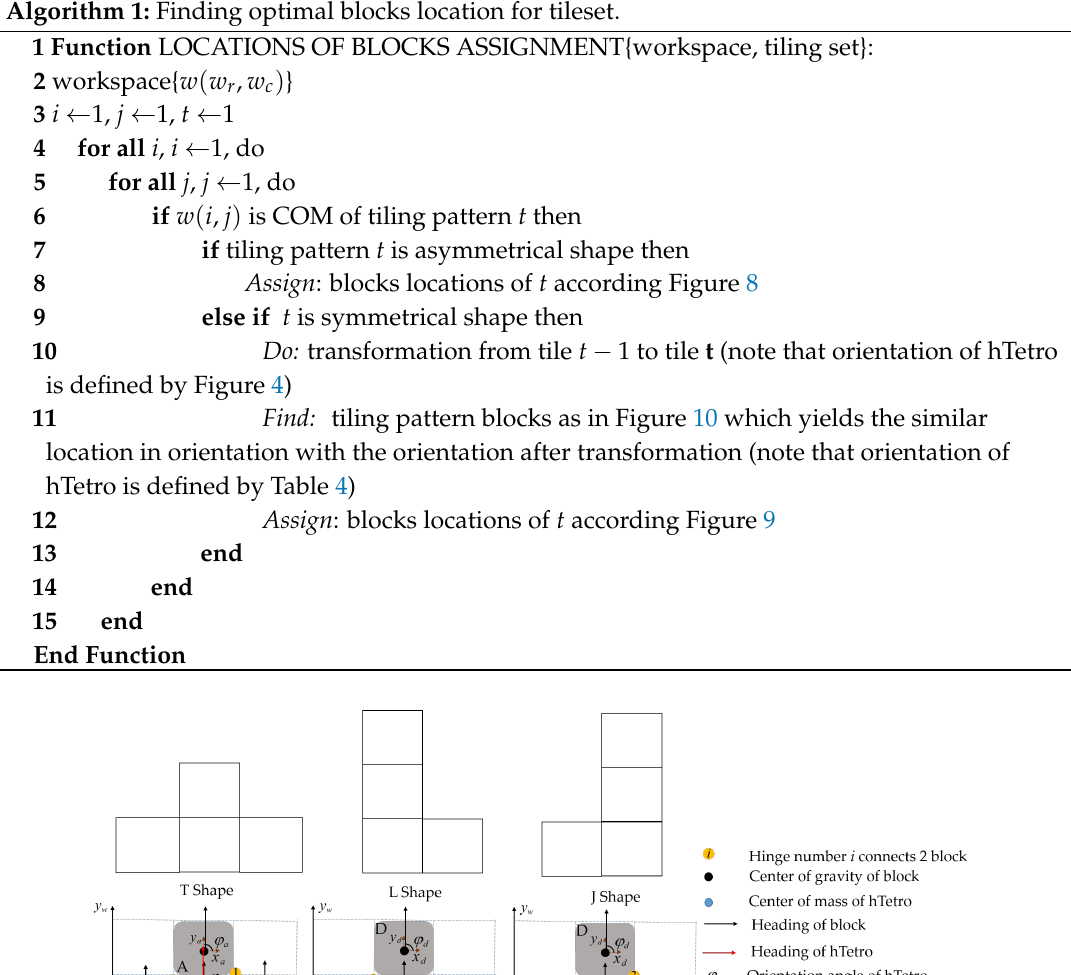
Algorithm 1: Finding optimal blocks location for tileset.